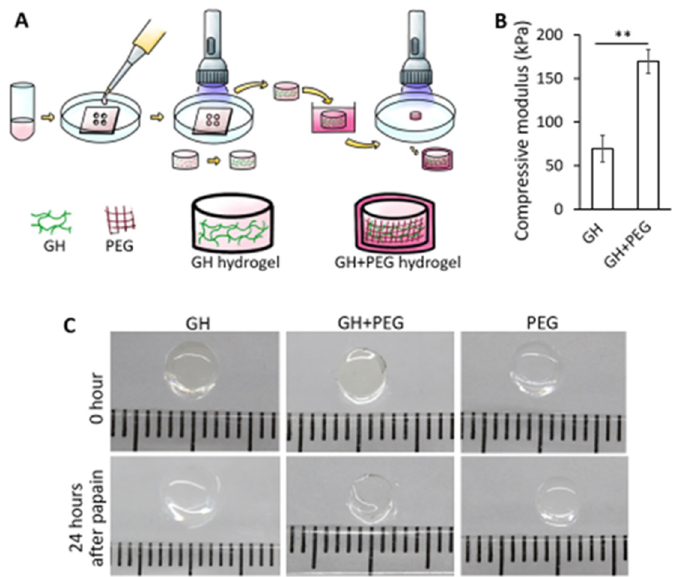
Figure 1. ( A ). The process of generating PEG-infiltrated GH (GH+PEG) scaffold. Specifically, uncured gelatin and hyaluronic acid (GH)/LAP (photoinitiator) solution were added into a mold with a cylindrical void space, then subjected to visible light illumination. Next, the pre-formed GH scaffold was soaked into Poly (ethylene glycol)-diacrylate (PEG)/LAP solution for 5 min. After PEG infiltration, the scaffold was photocrosslinked again to form the hybrid scaffold (GH+PEG). ( B ). Compressive modulus of GH and GH+PEG scaffolds. ( n = 4 scaffolds). ** p < 0.01. ( C ). The appearance of different hydrogel scaffolds before (top panel) and after (bottom panel) the treatment with papain.